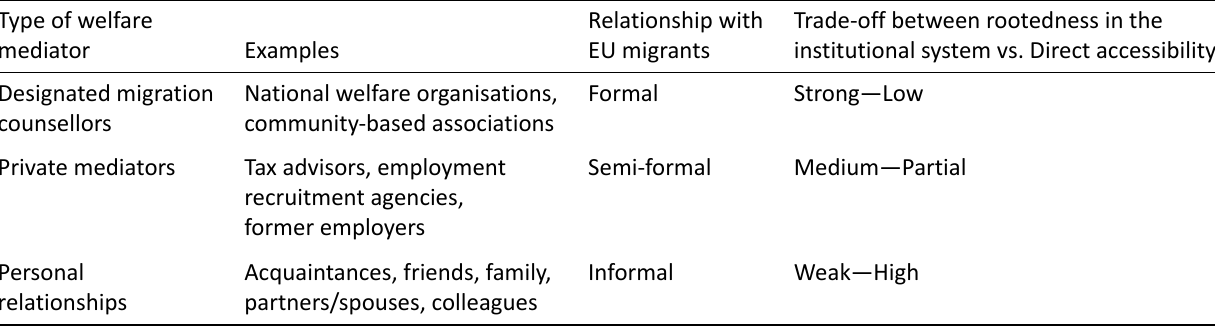
Table 2. A typology of welfare